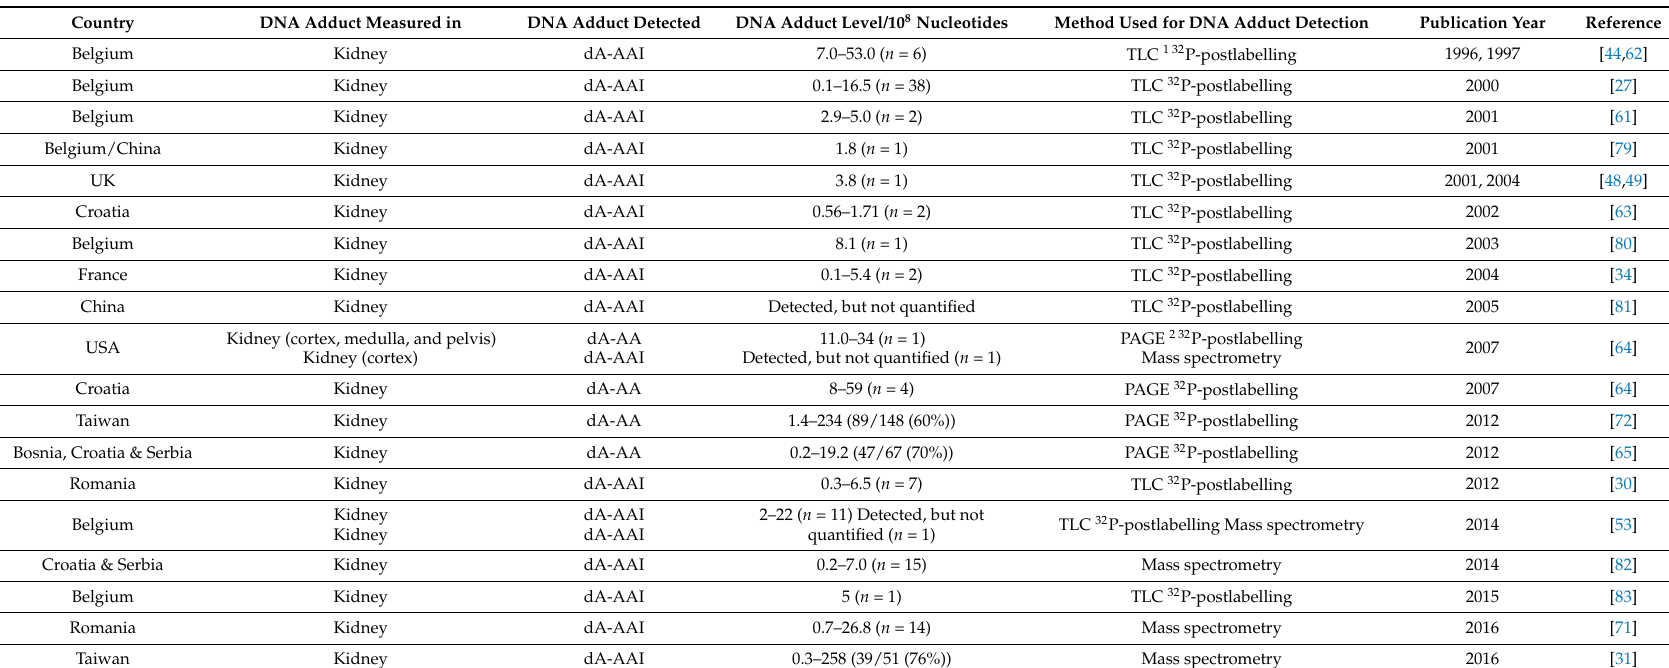
Table 1. DNA adduct levels (dA-AAI) in human renal tissue from individuals exposed to